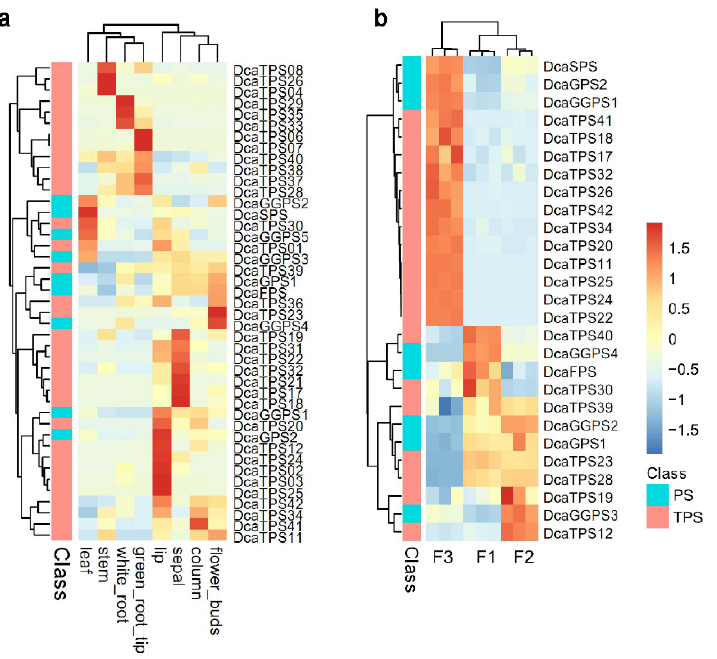
Figure 5. Spatiotemporal expression patterns of DcaPS-TPS genes. ( a ) Expression patterns of DcaPS- TPS genes in different tissues. ( b ) Expression patterns of DcaPS-TPS genes in three flowering phases. In the early developmental stage (F1), the column was short and lip crest were green; in the medium stage of flower bud development (F2), the column and lip had purple pigmentation; when the flower matured and opened (F3), the sepals and petals turned yellow and red pigmentation. Color scale represents the value of the relative expression level log 2